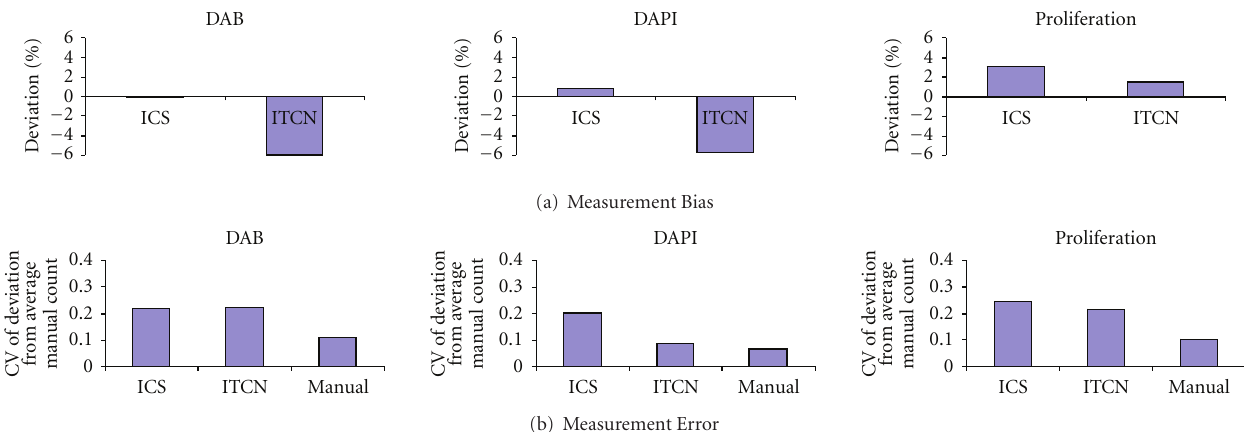
Figure 9: Measurement bias and error for automated and manual counts. (a) Measurement bias for automated counts using the ICS and ITCN methods. (b) Measurement error for ICS, ITCN, and manual cell counts.